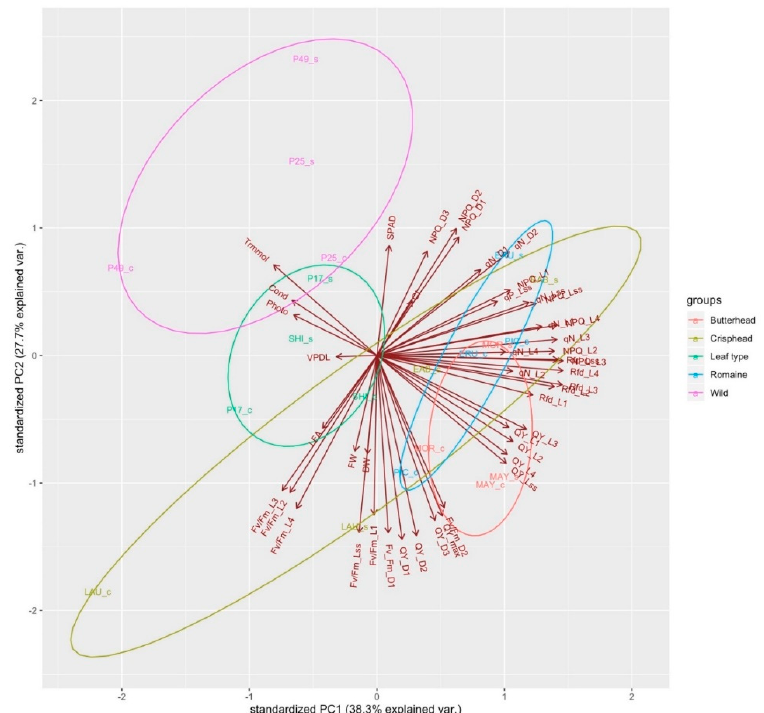
Figure 5. Principal component loading plot and scores of PCA on morphological, physiological, and chlorophyll fluorescence parameters of butterhead, crisphead, leaf-type, romaine, and wild lettuce grown in control and salinity conditions and grouped by colored ellipses around each lettuce type.